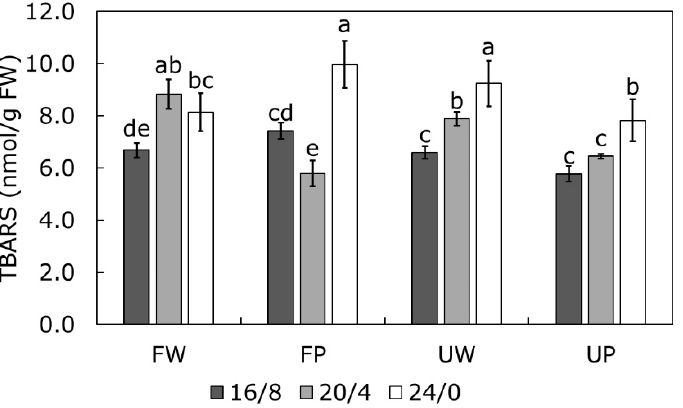
Figure 5. Changes in content of thiobarbituric acid reactive substances (TBARS, nmol/g FW) mea- sured in Cannabis cultivars Finola (F) and USO31 (U) exposed to 16/8, 20/4, and 24/0 photoperiods and grown under white (W) and purple (P) light. Results are shown as mean of five independent measurements (n = 5) ± SD. Different letters represent significant differences at p ≤ 0.05 (ANOVA, LSD); LSD = 0.187.